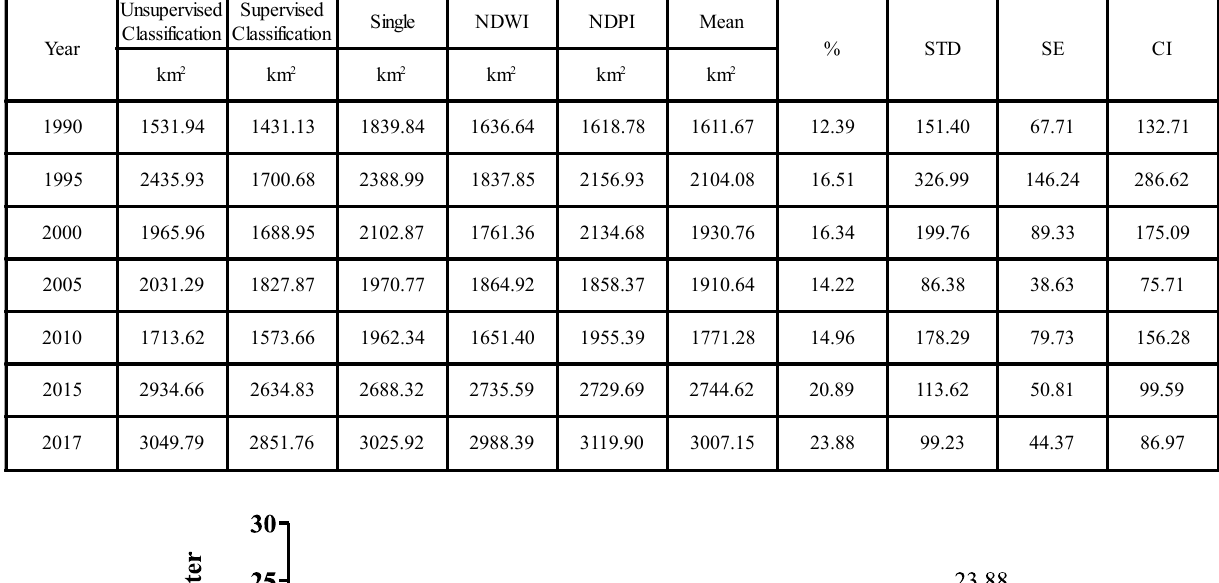
TABLE 5. STATISTICAL SUMMARY OF TEMPORAL DYNAMICS OF WATER BODIES IN THE INDUS DELTA Unsupervised Supervised Classification Classification Year